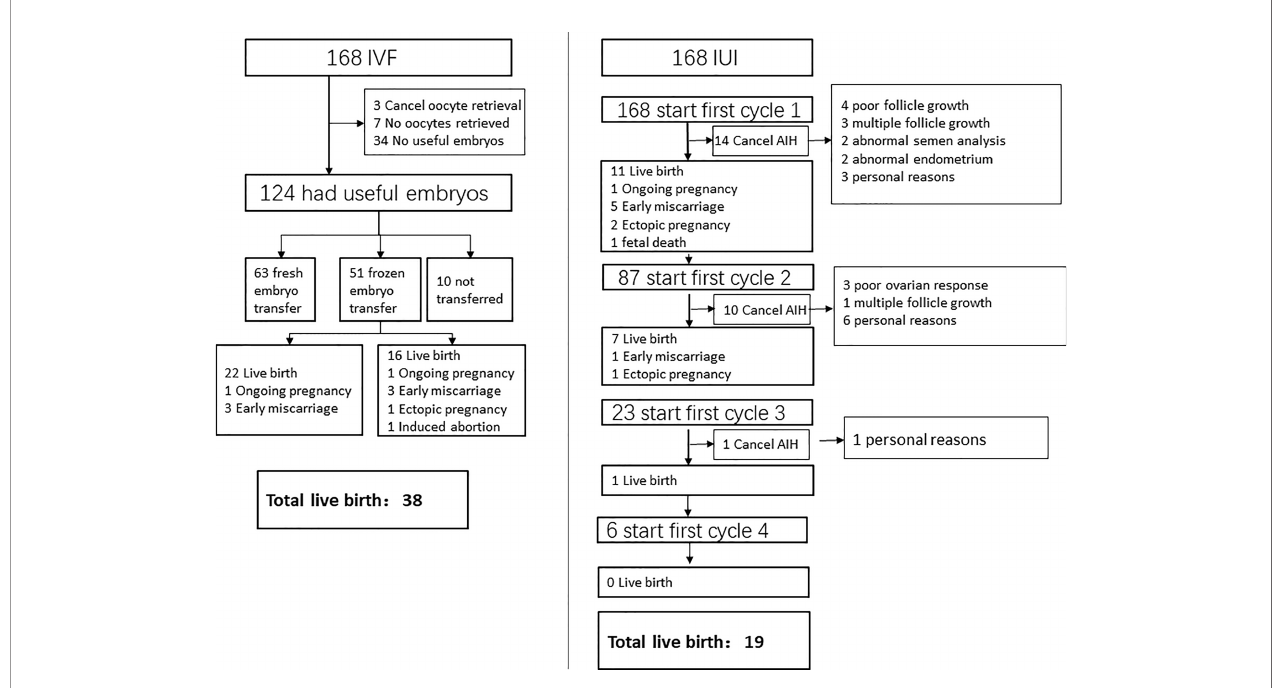
FIGURE 2 | Outcomes of patients following IVF and IUI.